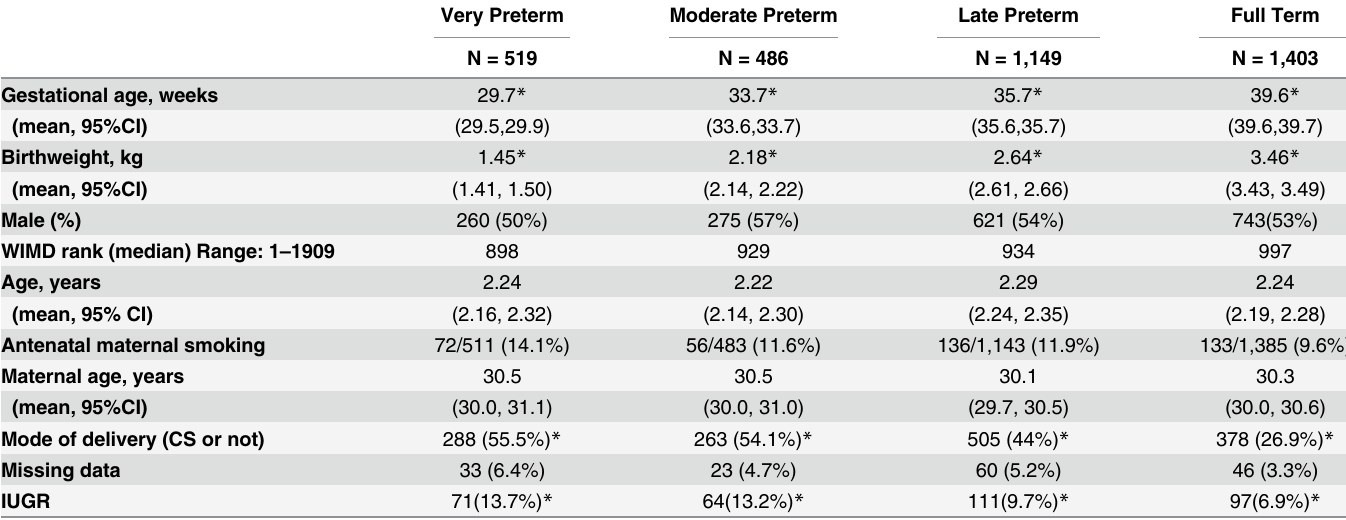
Table 1. Characteristics of responders < 5 years of age according to gestational groups.